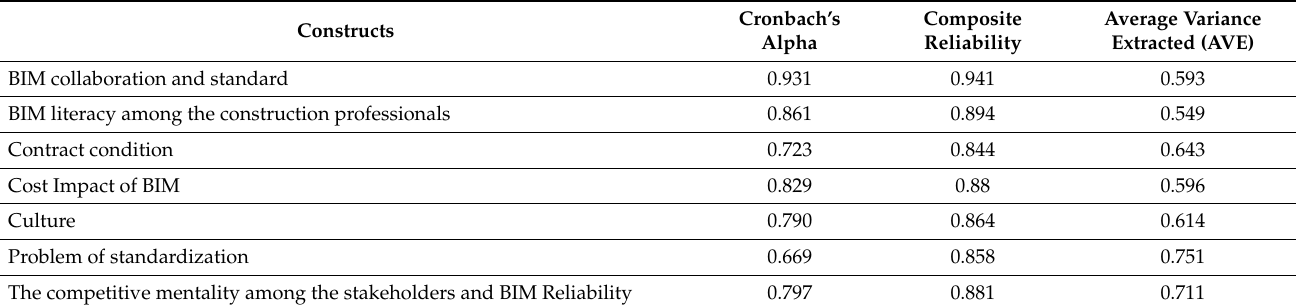
Table 6. Construct’s reliability and validity